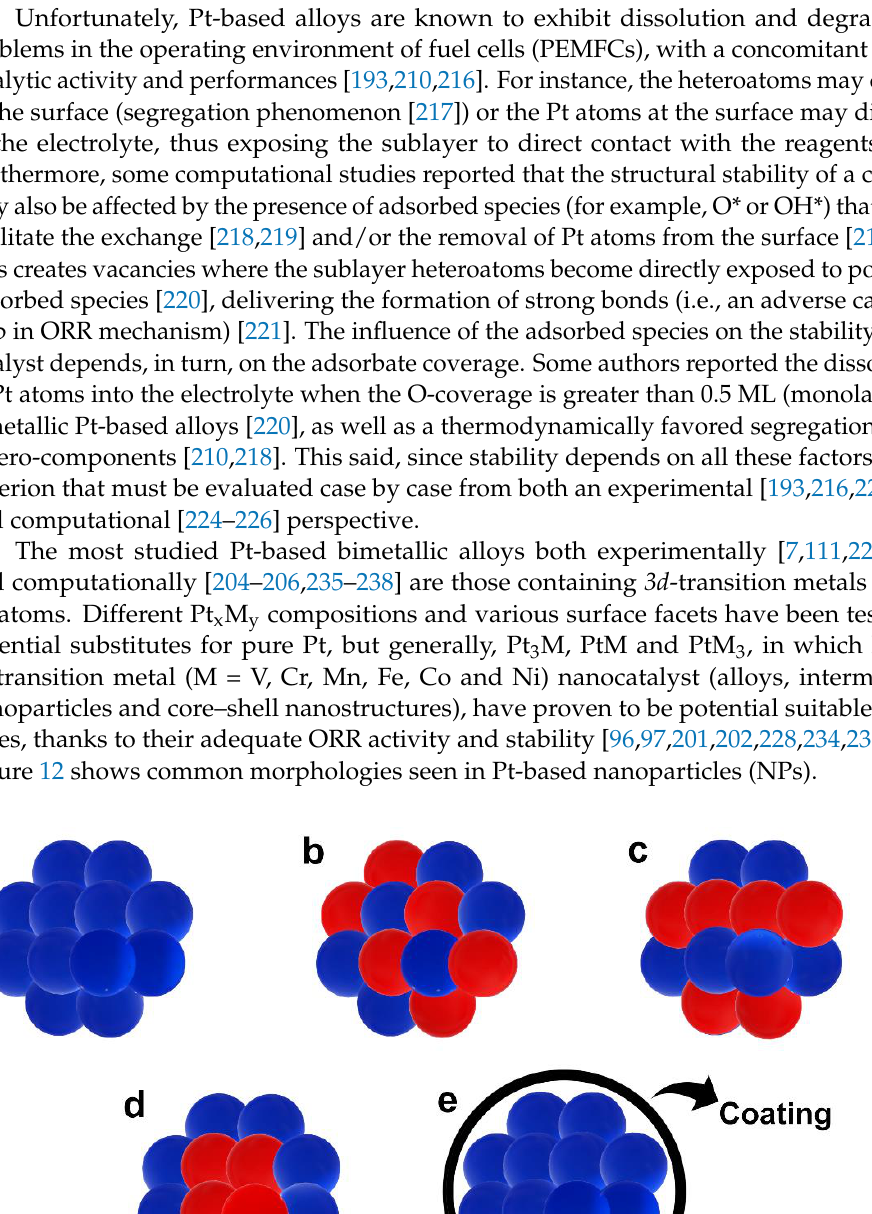
NPs are reported in Table 3, in comparison with commercially available Pt catalysts.